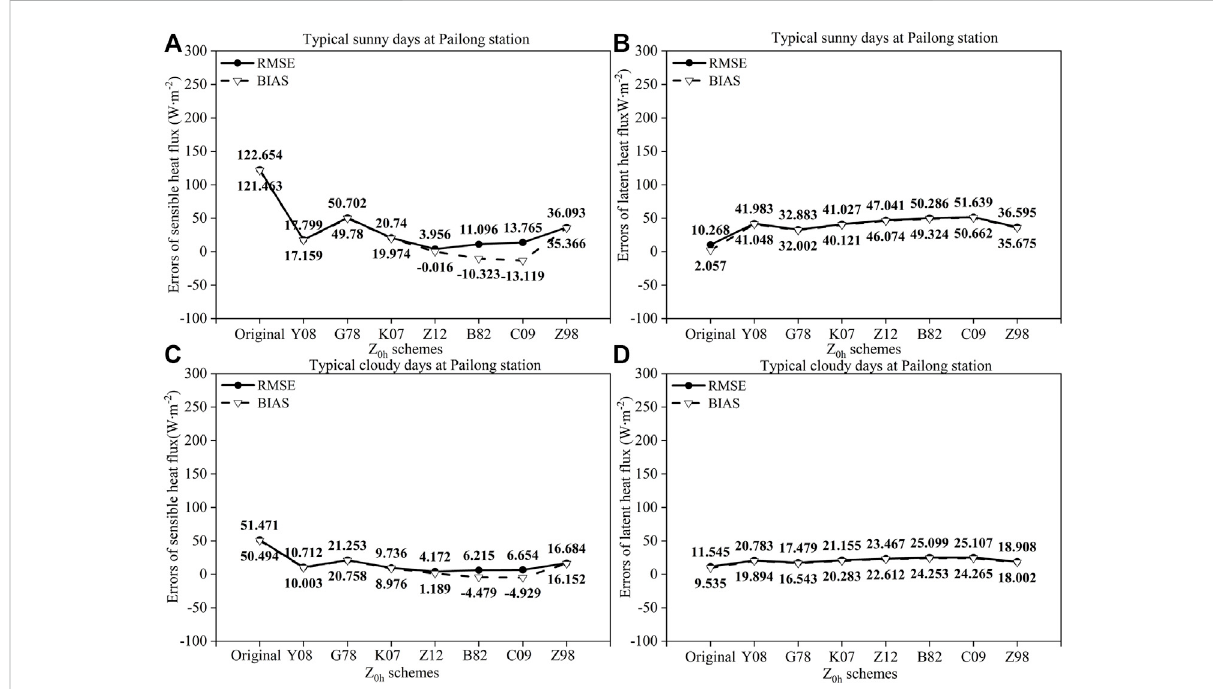
FIGURE 11 Root mean square error (RMSE) and BIAS between simulated and measured values for the period of strong turbulent exchange (12:00 – 16:00) under the typical sunny/cloudy days at Pailong station, (A and C) error in sensible heat fl ux (W · m − 2 ), (B and D) error in latent heat fl ux (W · m − 2 ).